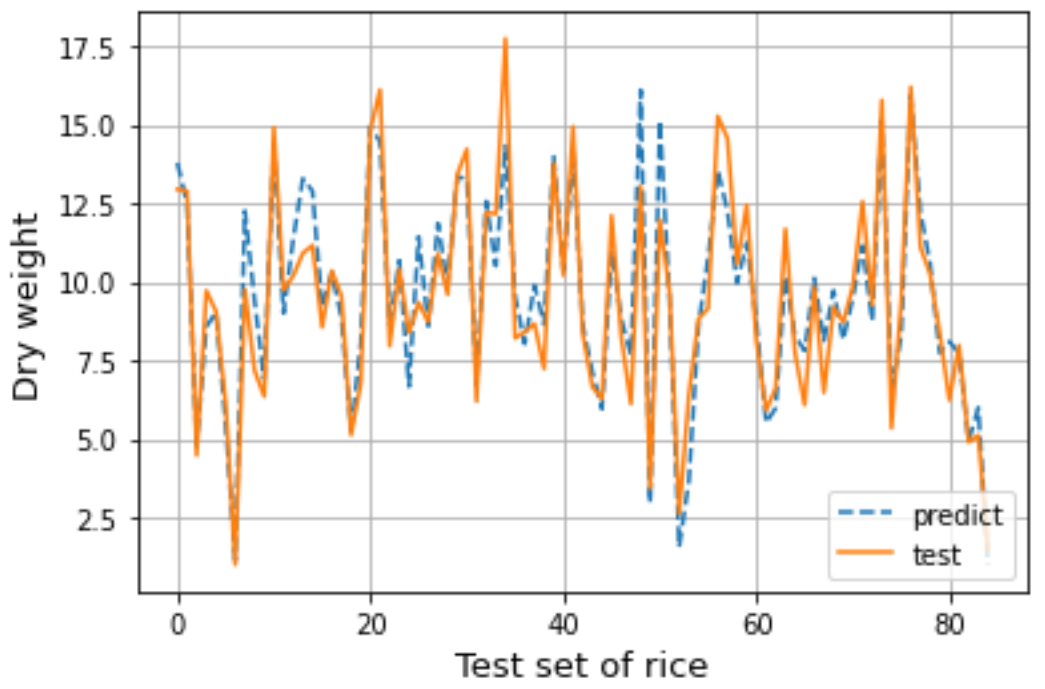
Figure 10. Fitting renderings of the linear regression model.